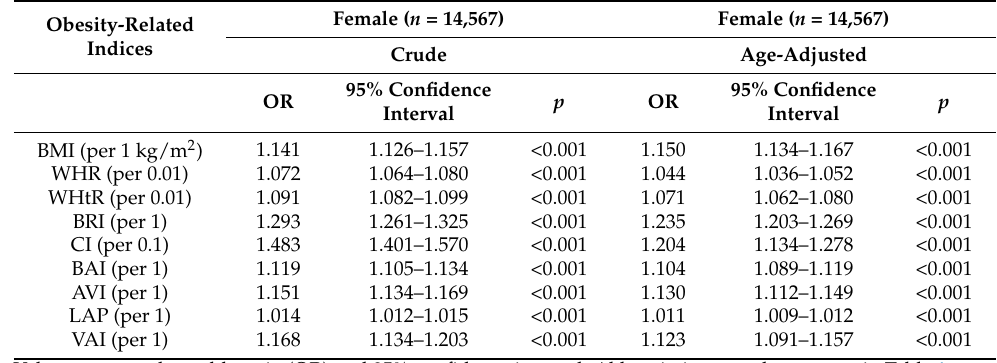
Table 4. Association of obesity-related indices with incident hypertension using univariable and age-adjusted logistic regression analysis in female participants.